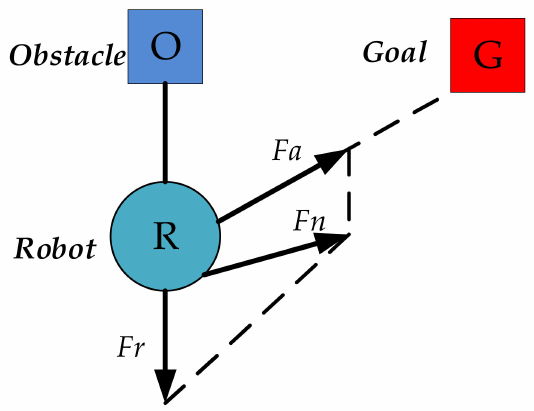
Figure 3. The force of the robot in the